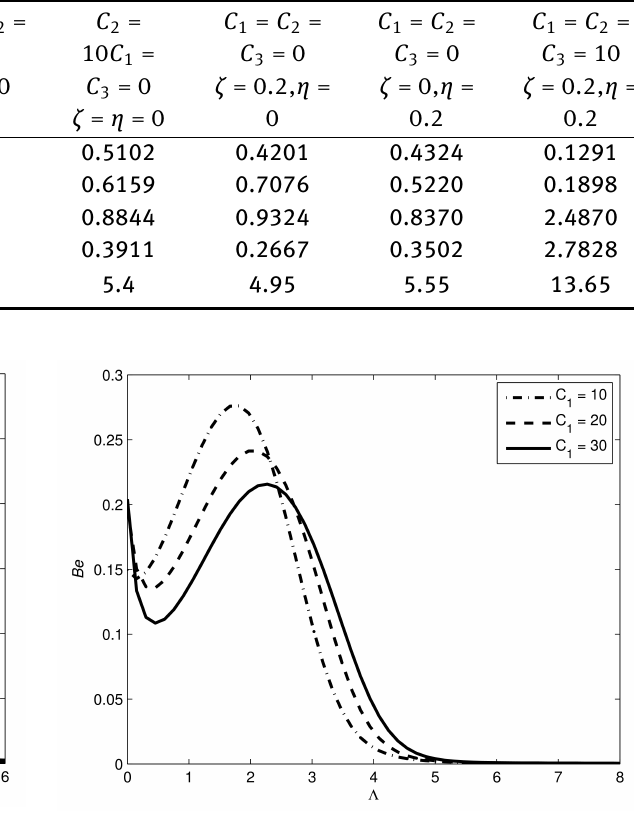
Figure 26: Effect of C 1 on Be keeping ζ = η = 0.2 , C 2 = C 3 = 10 ,